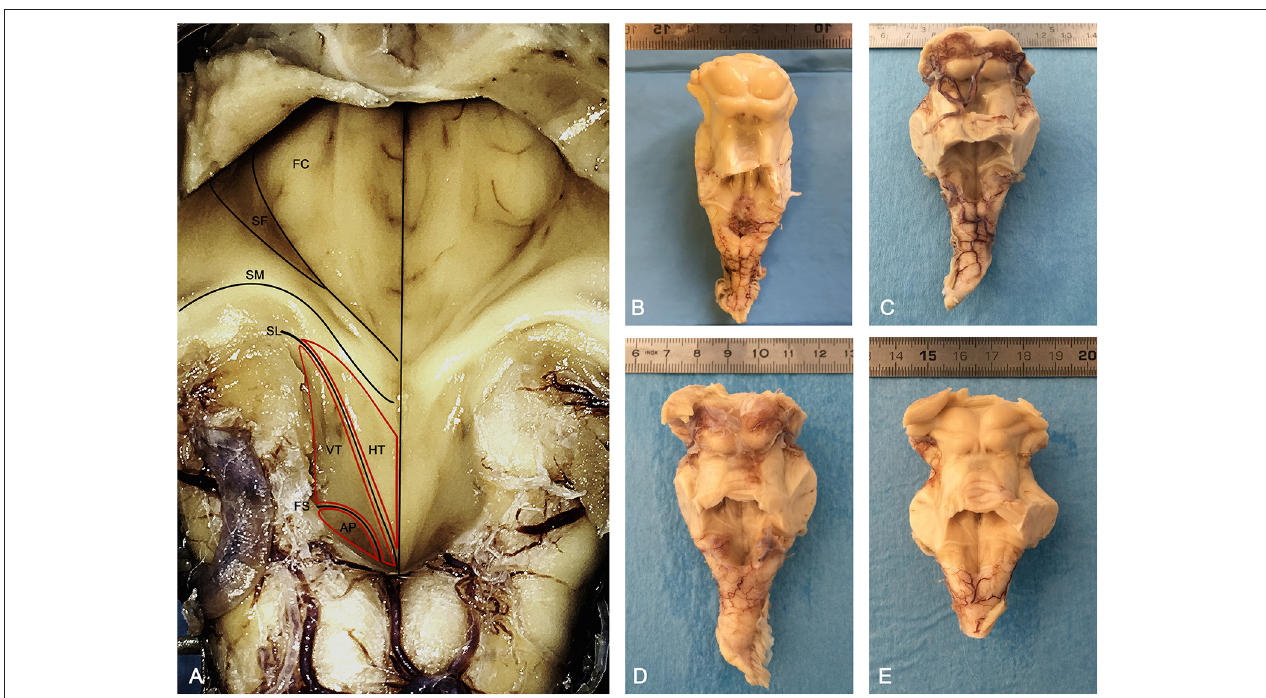
FIGURE 1 | Morphology of the human rhomboid fossa. (A) Structures and landmarks of the rhomboid fossa. The Vagal Trigone (Ala Cinerea) appears as a triangular structure emerging from the Calamus Scriptorius and ending with its apex at the level of the Striae Medullares; caudally it is separated from the Area Postrema by the Funiculus Separans. AP, Area Postrema; FS, Funiculus Separans; VT, Vagal Trigone (Ala Cinerea); HT, Hypoglossal Trigone (Ala Bianca Interna); SL, Sulcus Limitans; SM, Striae Medullares (Acustic Striae of Piccolomini); SF, Superior Fovea; FC, Facial Colliculus. (B–E) Posterior view of four brainstems employed in the study, anatomically sectioned at the level of the mesencephalon, cranially to the superior colliculi, and at the level of the cerebellar pedicles.